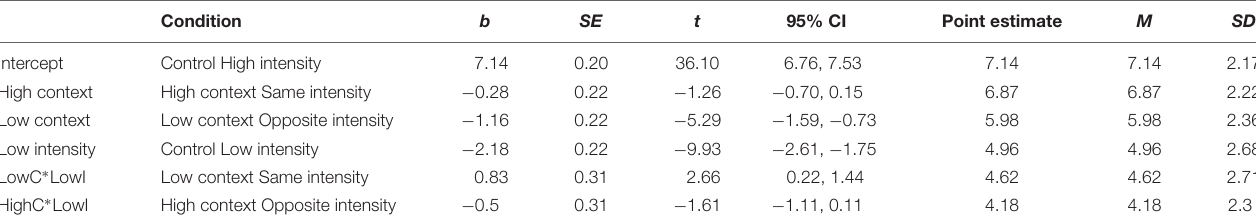
FIGURE 3 | Point estimates derived from the model for each of the conditions. Red and blue lines plot genuineness ratings of interactions containing high and low intensity laughter, respectively. Although interactions containing low intensity laughter were consistently judged less genuine than those containing high intensity laughter, both sets of data reveal a similar trend. In both cases there was no significant change in genuineness ratings when laughter in an original interaction was replaced with similar intensity laughter. However, replacements with laughter of the opposite intensity result in a measurable reduction in genuineness ratings. Error bars represent 95% Confidence Intervals. TABLE 1 | Table of the fixed effects factors for the multi-level model of laugh responses for Experiment